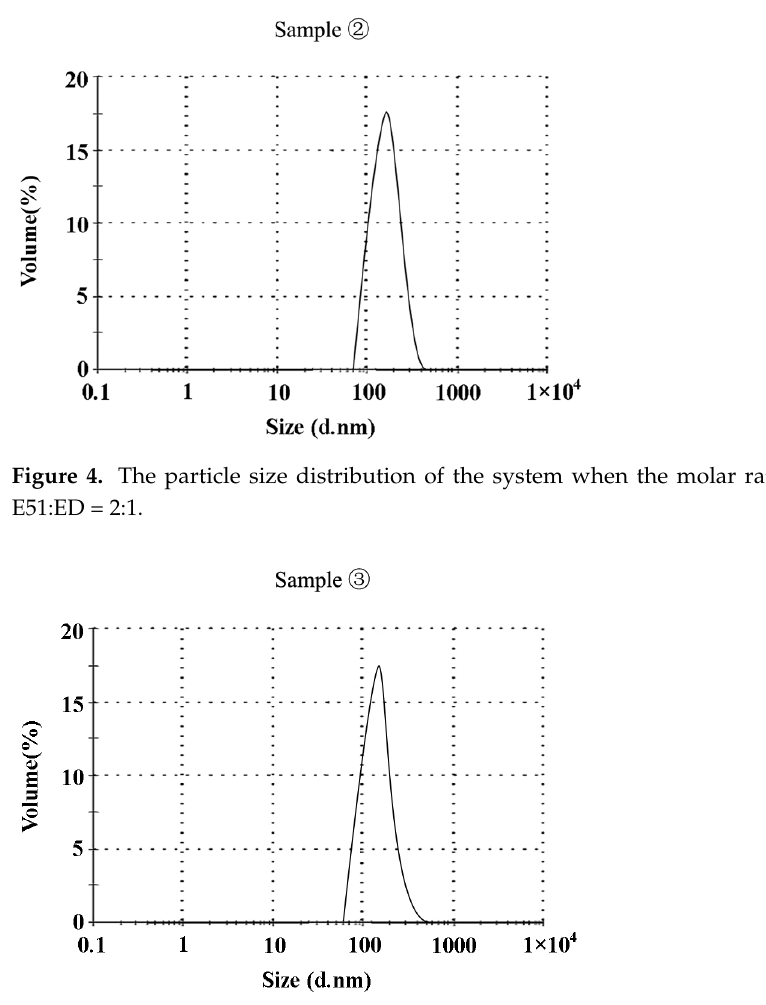
Figure 5. The particle size distribution of the system when the molar ratio of epoxy groups is E-51:ED = 1.5:1.